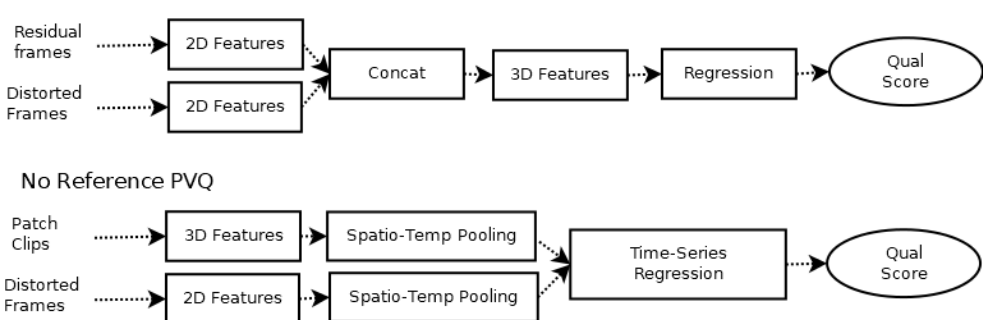
Figure 6. Example comparison of FR C3DVQA and NR PVQ algorithms. While these still roughly fit into our framework, suggesting there is at least some potential to bring FR and NR on the same or similar footing, they still differed in detail, tampering any over